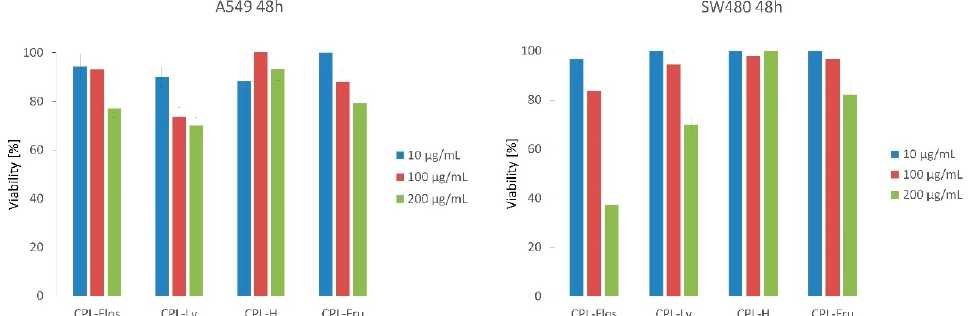
Figure 2. Antiproliferative activity of crude rose polysaccharides expressed in % viability. Abbreviations like in Table 2.